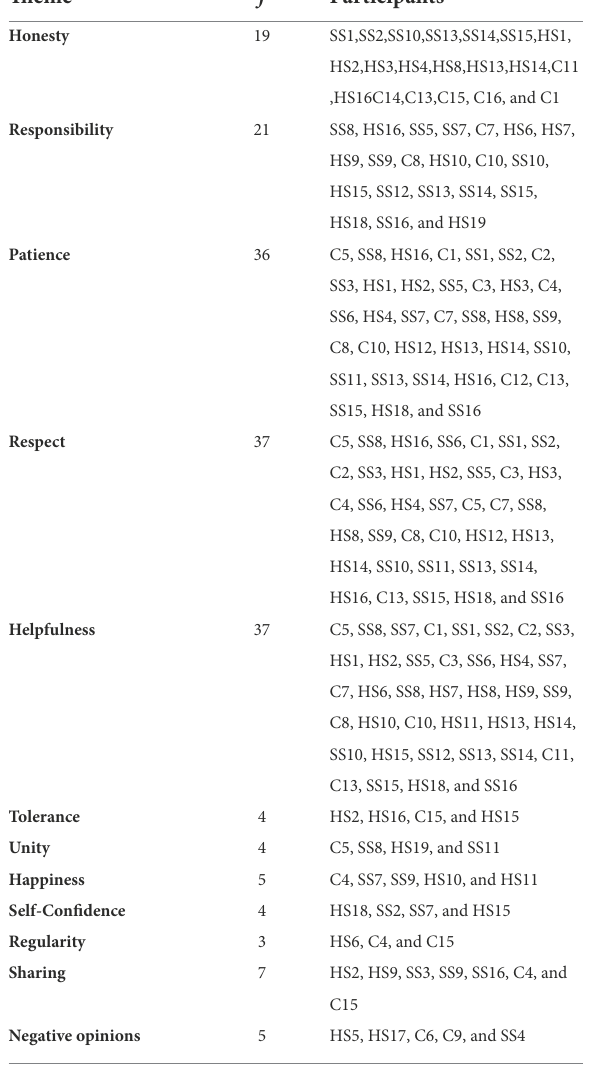
TABLE 2 Universal values toward which sensitivity is developed in socio-cultural trips. Theme